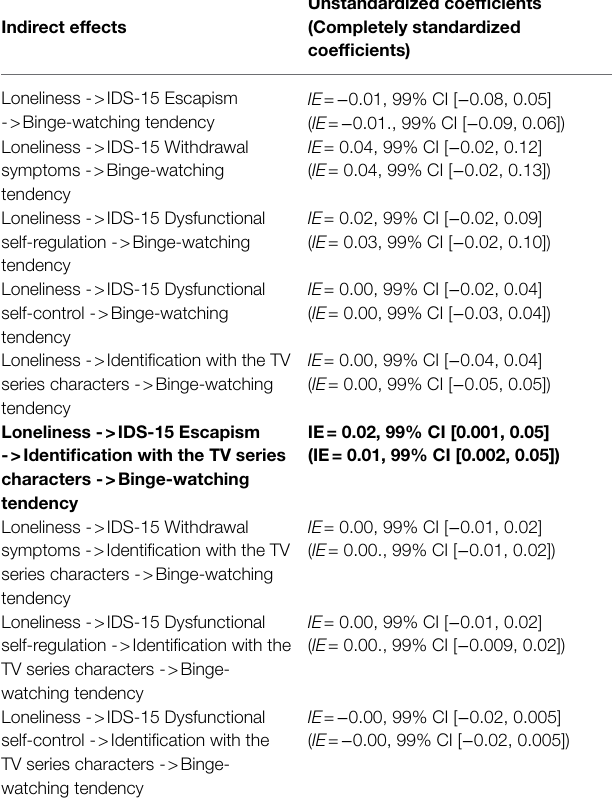
TABLE 3 | Indirect effects. Indirect effects